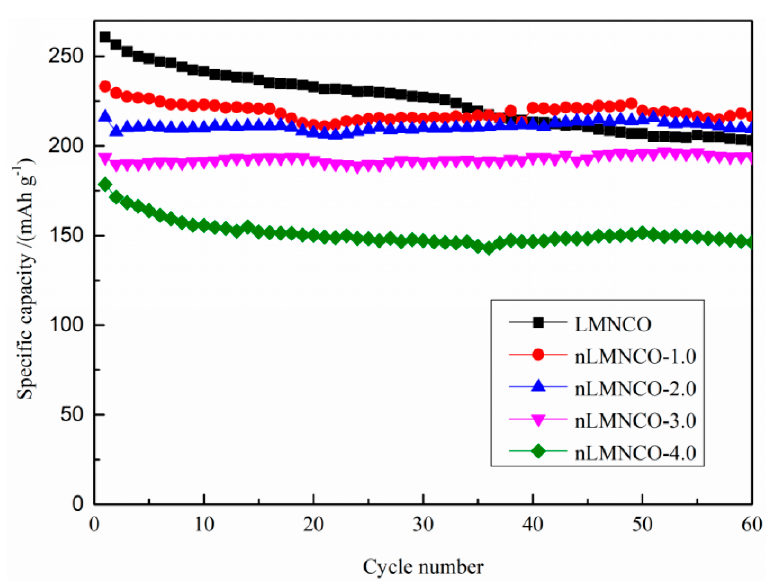
Figure 7. Cycling performance of cathode materials at 0.2 C.